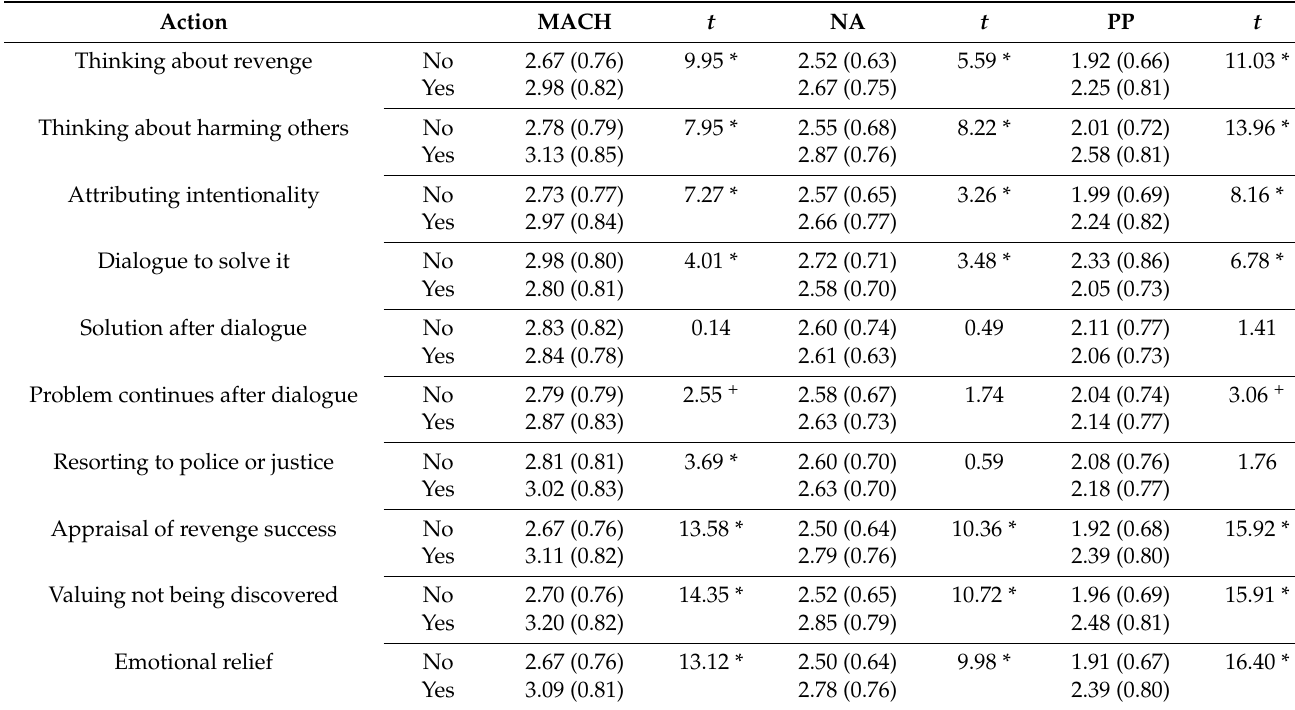
Table 2. Averages and standard deviations of the variables of the Dark Triad as a function of vengeful actions. Action MACH t NA t PP t Thinking about revenge